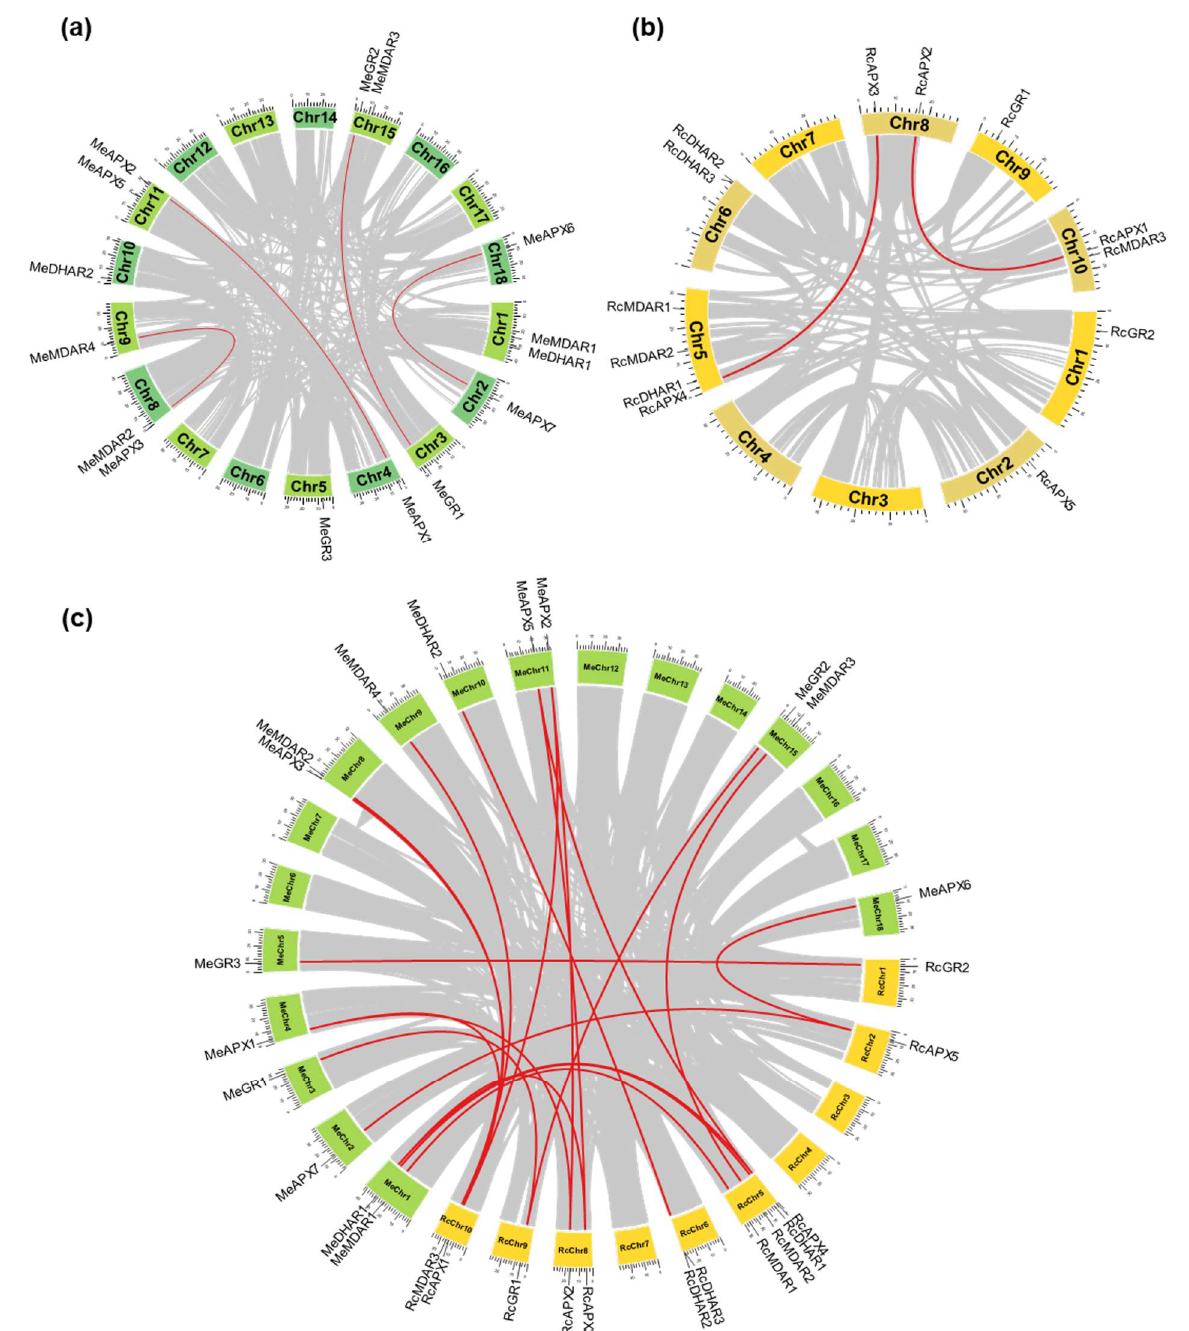
Figure 2. Chromosomal positions and inter-chromosomal groups of duplicated APX, MDAR, DHAR, and GR genes pairs in Ricinus communis ( a ) and Manihot esculenta ( b ). Gray lines in the background demonstrate all syntenic blocks and the red lines exhibit the segmental or tandem duplication network zones. The approximate location of APX, MDAR, DHAR, and GR genes is marked with black lines outside the chromosome names. The syntenic analysis among the Ricinus communis and Manihot esculenta genomes is indicated in ( c ).